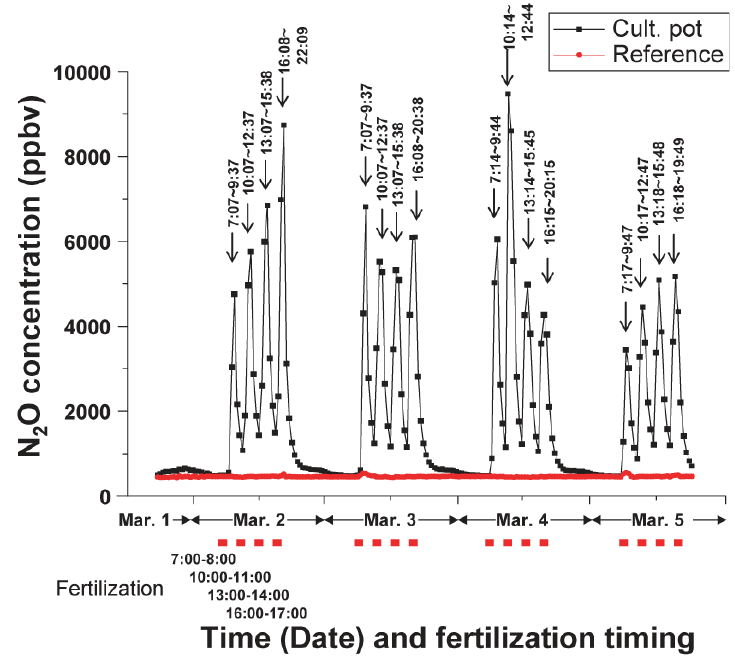
O gases from a tomato plant cultivated Figure 8. Variation in concentration of N 2 hydroponically on rock wool. The black line shows the data from the cultivation pot and the red line shows the data from the reference pot. Black arrows and red symbols indicate peak duration and fertilization timing,